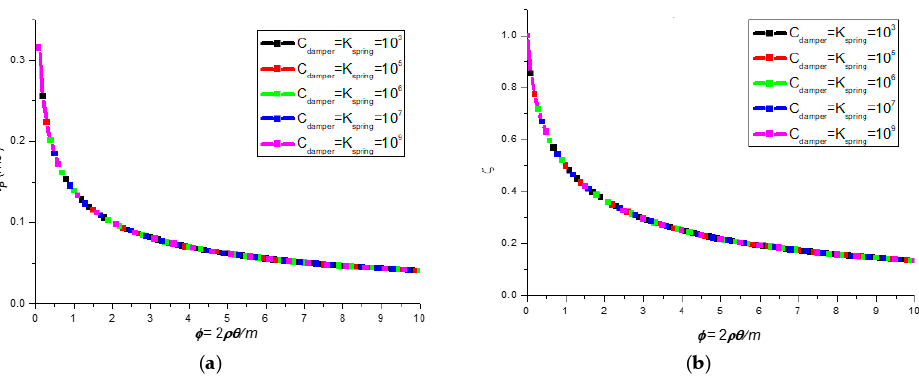
Figure 6. ( a ) Dependence of the peak momentum time and ( b ) the momentum transfer coe ffi cient upon the fluid–structure interaction (FSI) parameter φ 1 = 2 ρ c θ / m